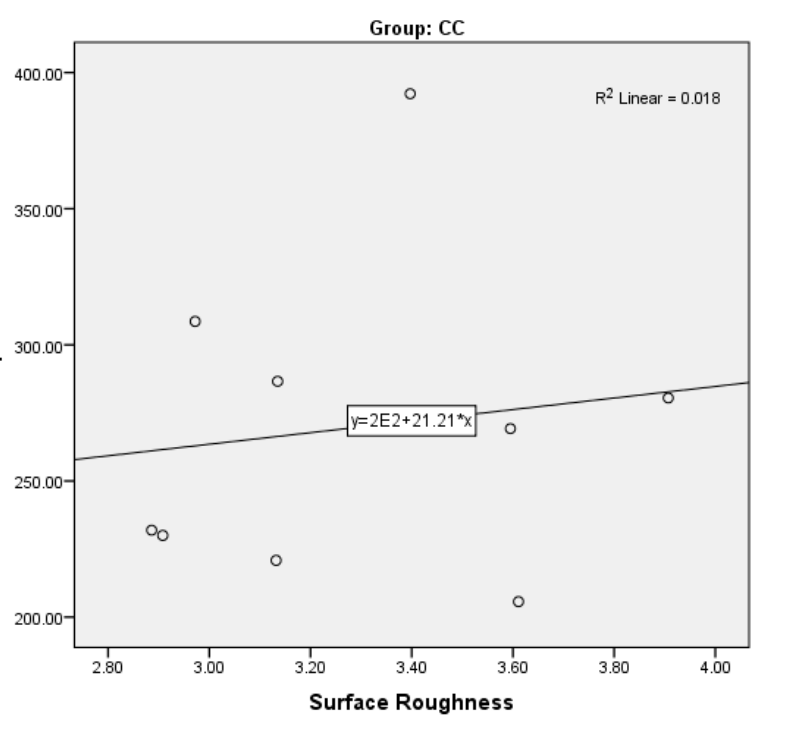
Figure 9. Scatter plot for the correlation between adaptation and surface roughness for the 3D samples.